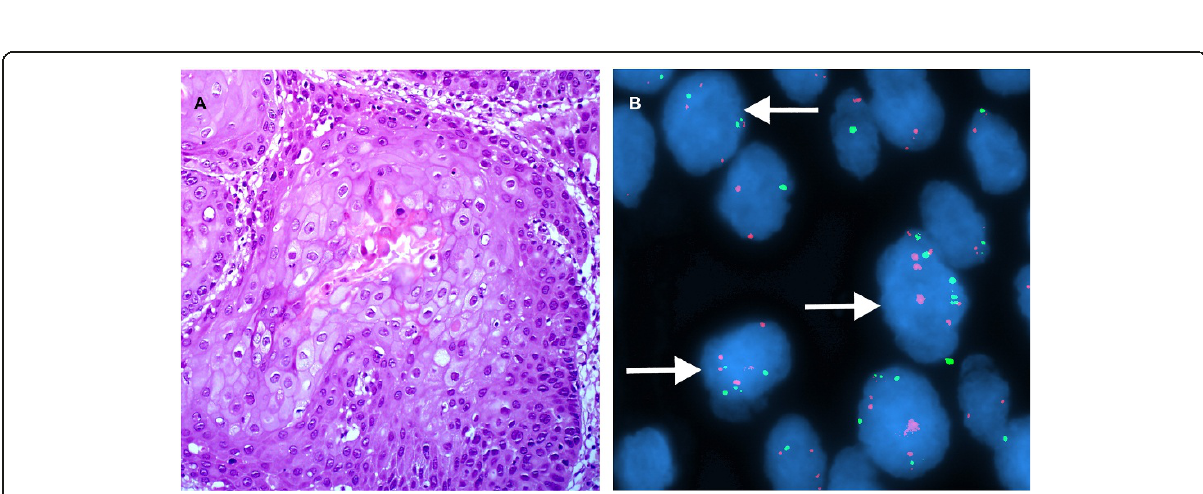
Figure 6 A case of invasive carcinoma . A. H&E stain. (×200). B. Interphase FISH shows the CSP3: hTERC signal pattern is 3:4, 5:5, 5:7, and etc.